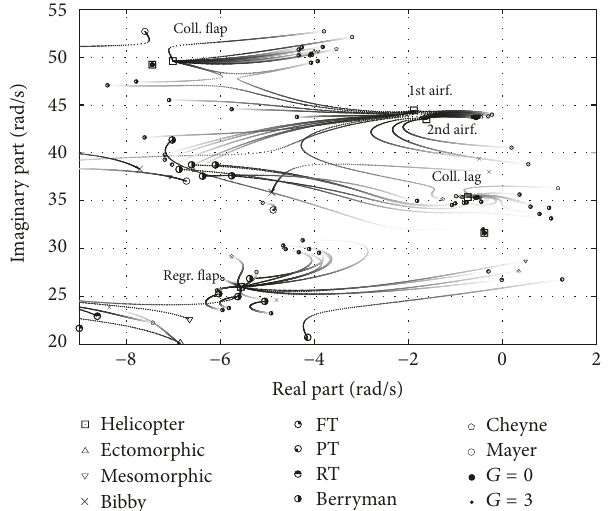
Figure 7: Collective control pilot-in-the-loop root loci, for gearing ratio increase, enlargement. The most relevant aeroelastic poles in RPC are indicated.